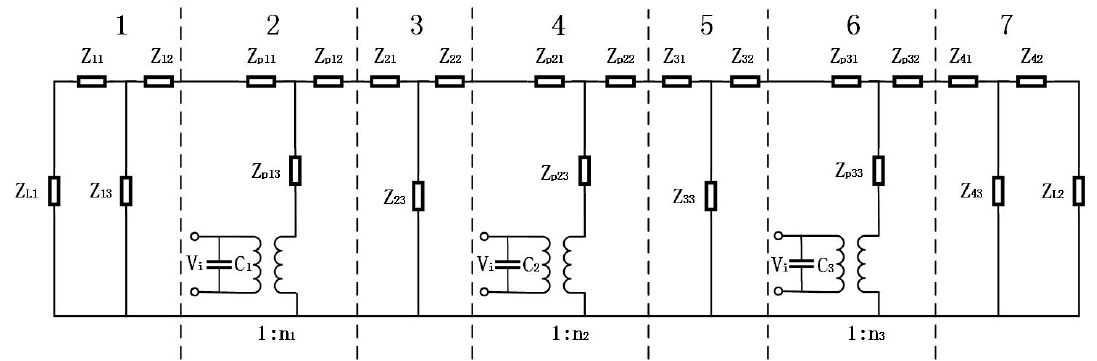
Figure 3. Electromechanical equivalent circuit of the cascaded piezoelectric ultrasonic transducer with three sets of piezoelectric ceramic stacks.